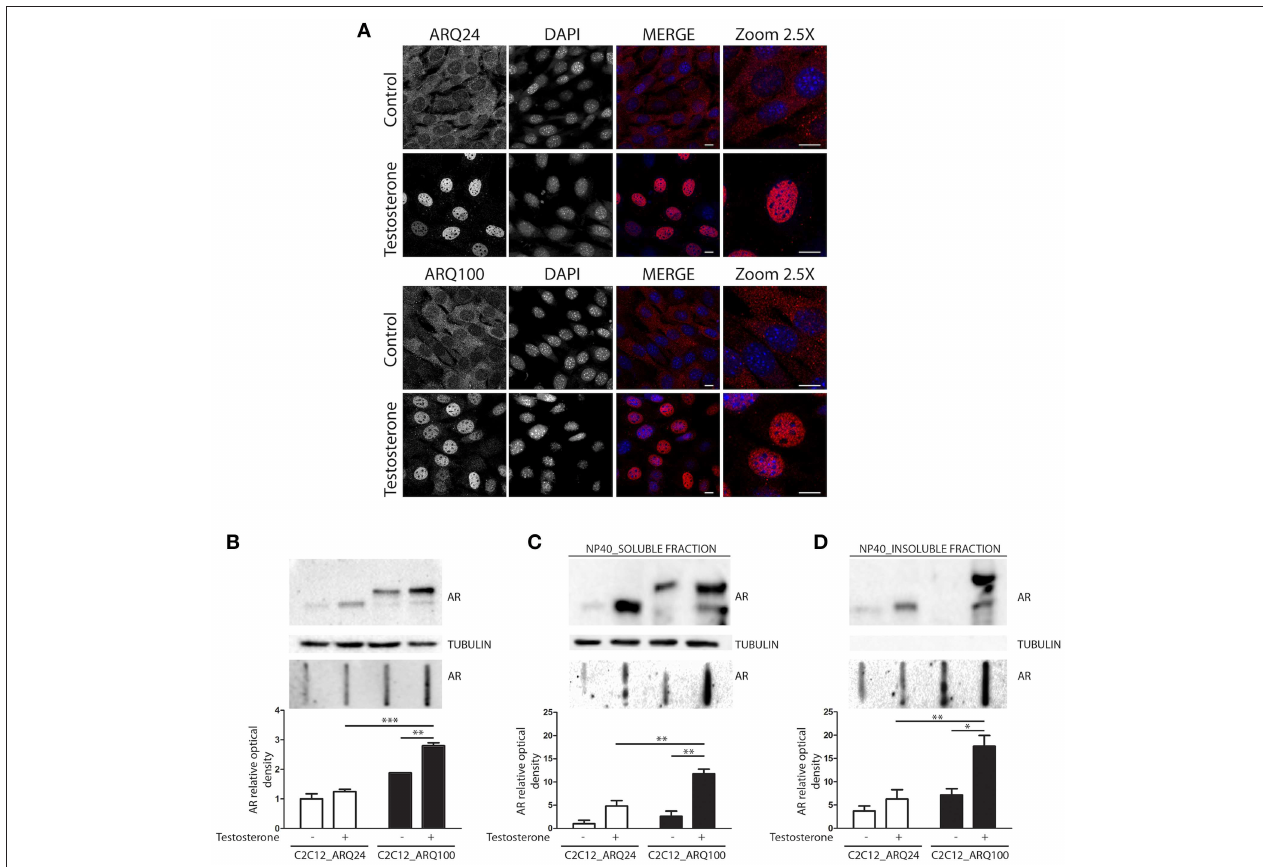
FIGURE 1 | Characterization of the cellular model. (A) Immunostaining for AR. Nuclei staining: DAPI. 60X magnification. Confocal microscope: Eclipse T i 2 (Nikon). Scale bar = 10 µ m (B) WB (upper inset) and FRA (middle inset) of PBS extracts. Optical densitometry quantification of FRA (lower inset). *** p < 0.001 vs. ARQ24 + T; ** p > 0.01 vs. ARQ100-T. (C) WB (upper inset) and FRA (middle inset) of NP-40 soluble extracts. Optical densitometry quantification of FRA (lower inset). (** p < 0.01 vs. ARQ24 + T or vs. ARQ100-T). (D) WB (upper inset) and FRA (middle inset) of NP-40 insoluble extracts. Optical densitometry quantification of FRA (lower inset). (** p < 0.01 vs. ARQ24 + T; * p < 0.05 vs. ARQ100-T). Two-way ANOVA followed by Bonferroni post-hoc test was used. Each experiment was independently replicated three times. Graphs show quantification of three independent biological samples ( n =